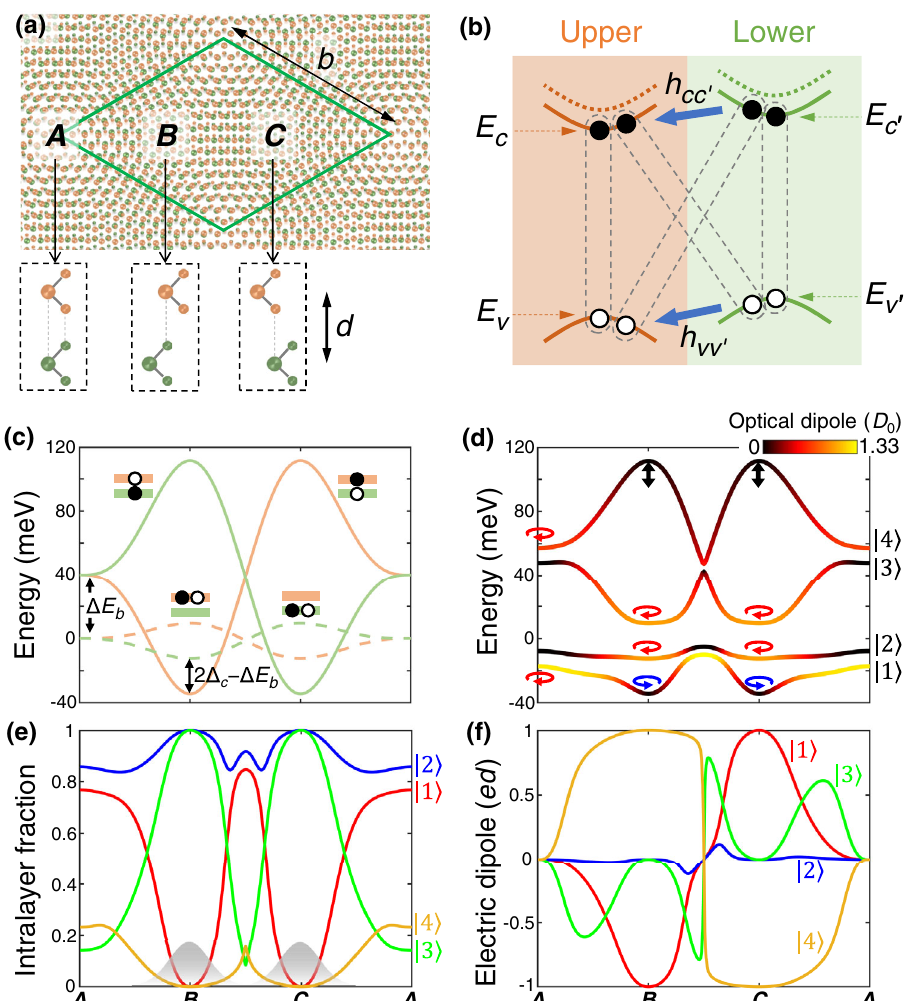
FIG. 1. Hybridization of inter- and intralayer excitons in a homobilayer moir´e. (a) Schematic illustration of a near R -type twisted homobilayer moir´e. The green diamond is a supercell, which has three high-symmetry local regions A , B , and C with different atomic registries. (b) Excitons of intralayer ( X ) and interlayer ( X ) configurations. At a general location in the moir´e, the intra inter interlayer coupling manifests as the off-diagonal hopping of the electron and hole ( h and h ) and the diagonal energy shifts of the cc 0 vv 0 band edges in the two layers which results in a modest type-II band offset of approximately O ð 10 Þ meV. (c) Solid (dashed) lines indicate the energies of X ( X ), along the long diagonal of the supercell in (a). (d) Moir´e potentials for the four decoupled inter intra exciton branches, each of which is a hybridization of X and X by the electron and hole interlayer hopping (cf. the main text). inter intra The optical dipole strength is color coded in units of D 0 , the optical dipole of X . (e) Fraction of X in each branch. The shaded intra intra wave packets indicate excitons trapped at B and C in the lowest-energy branch j 1 i . (f) The electric dipole of each branch in units of ed